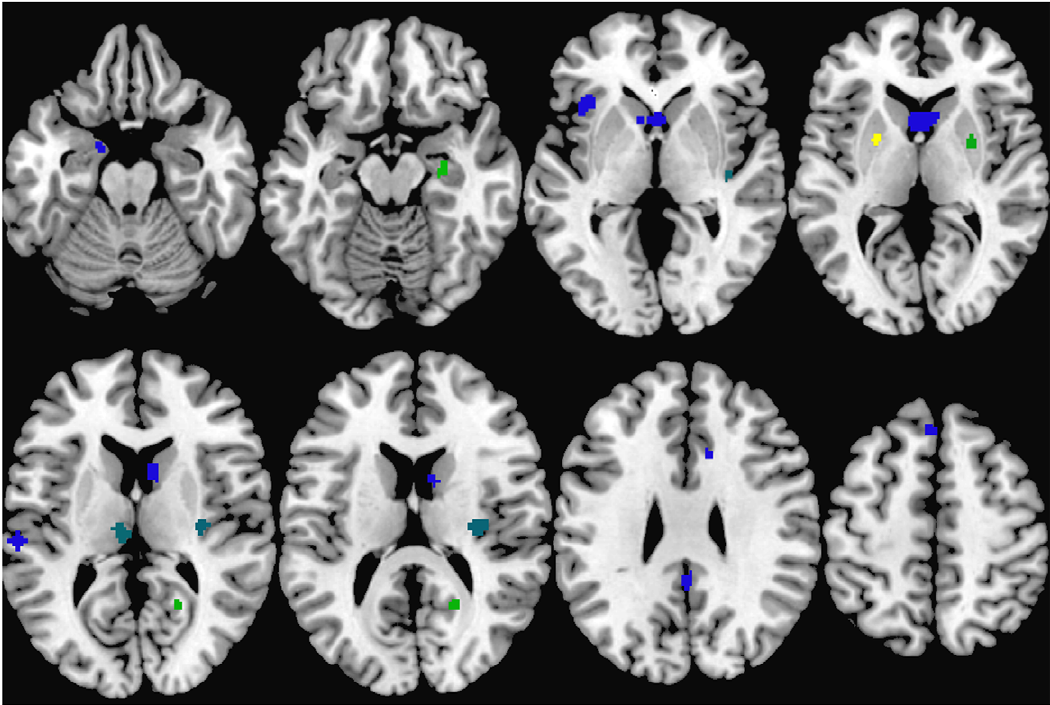
Figure 1. Lower grey matter volumes in ASD and Schizophrenia. Clusters indicating relationship between brain regions and condition are colour-coded as follows: blue for clusters contributed to mostly by schizophrenia studies, yellow for clusters contributed to mostly by ASD studies, and green for clusters contributed to by both conditions.